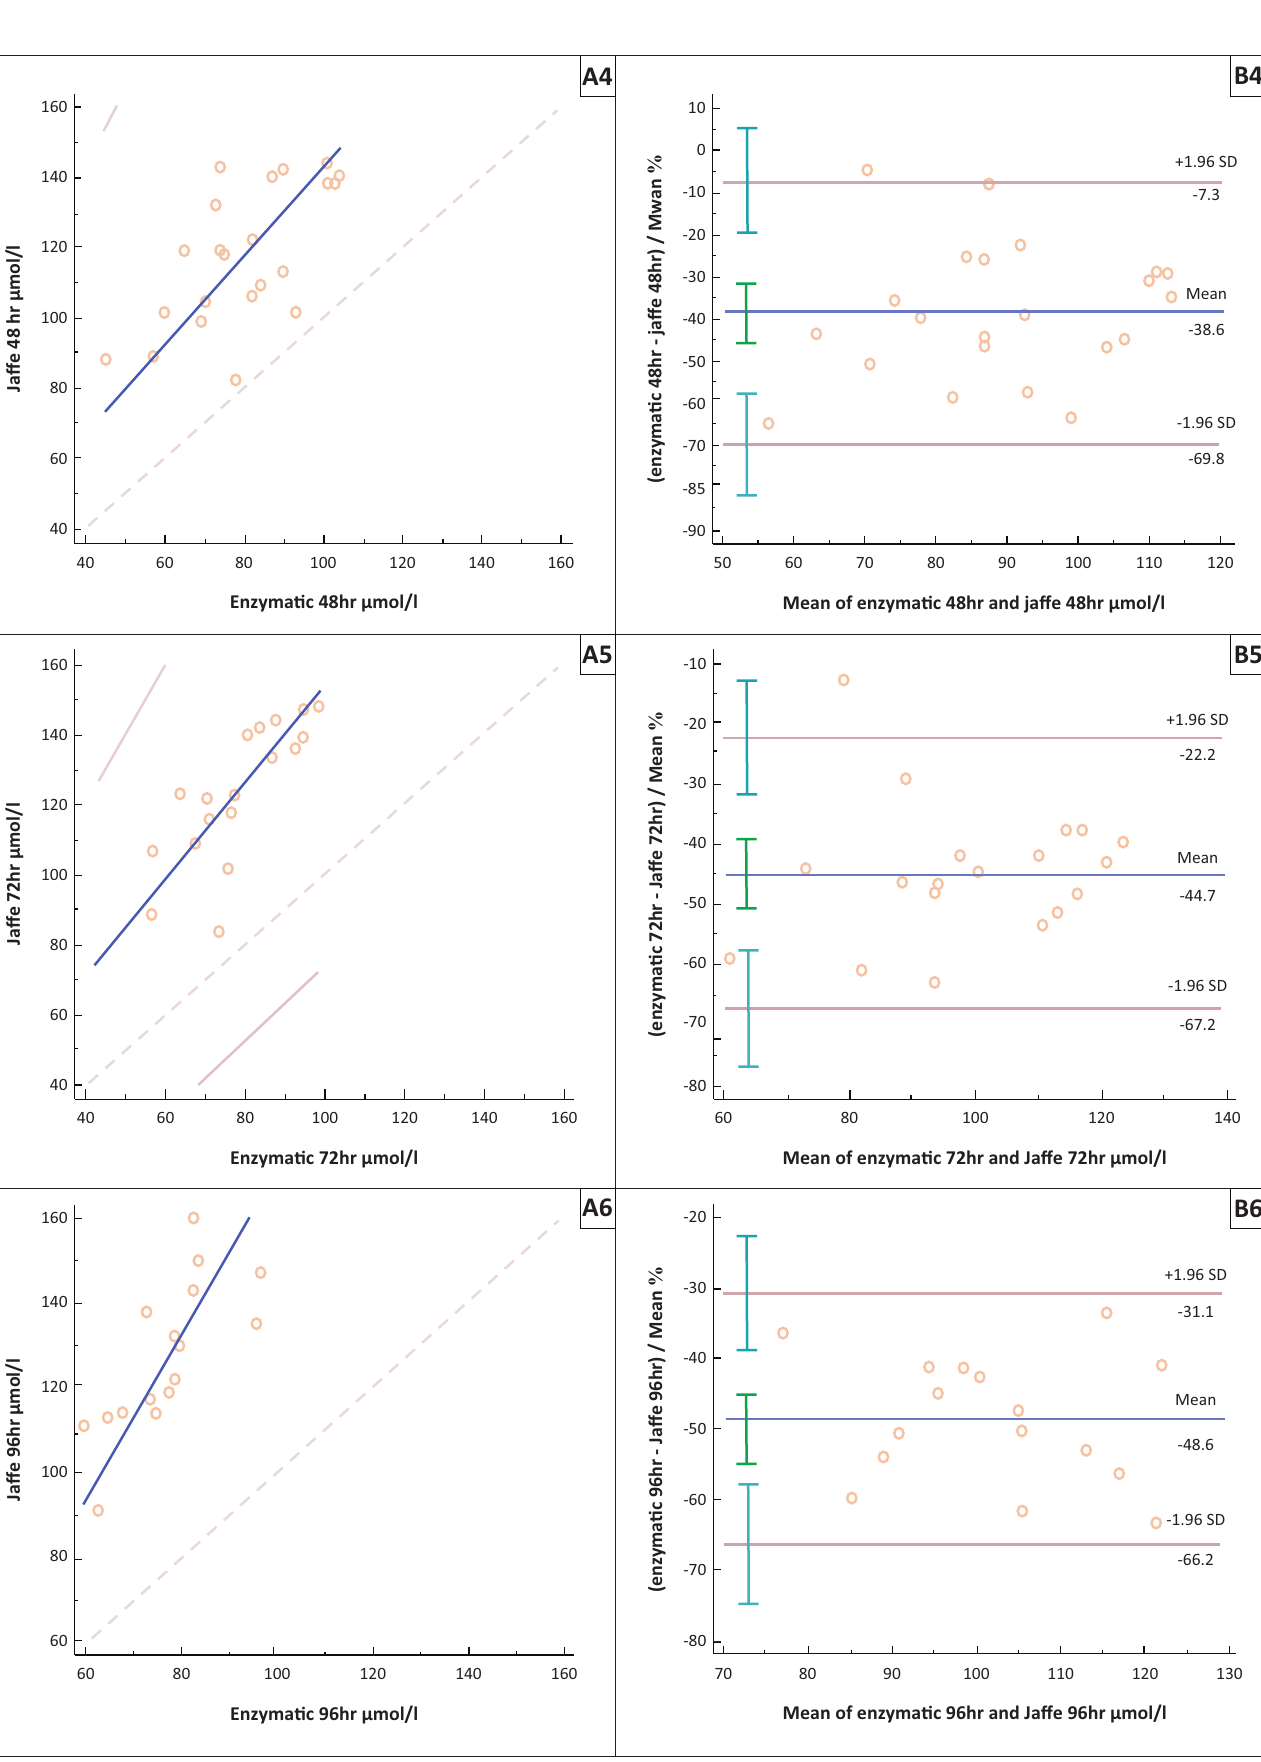
FIGURE 3 (Continues...): Passing-Bablok regression curves (A) and Bland-Altman plots (B) comparing creatinine concentrations from the kinetic Jaffe method with those from the enzymatic method. Creatinine concentrations at (1) < 4 h, (2) 6 h, (3) 24 h, (4) 48 h, (5) 72 h and (6) 96